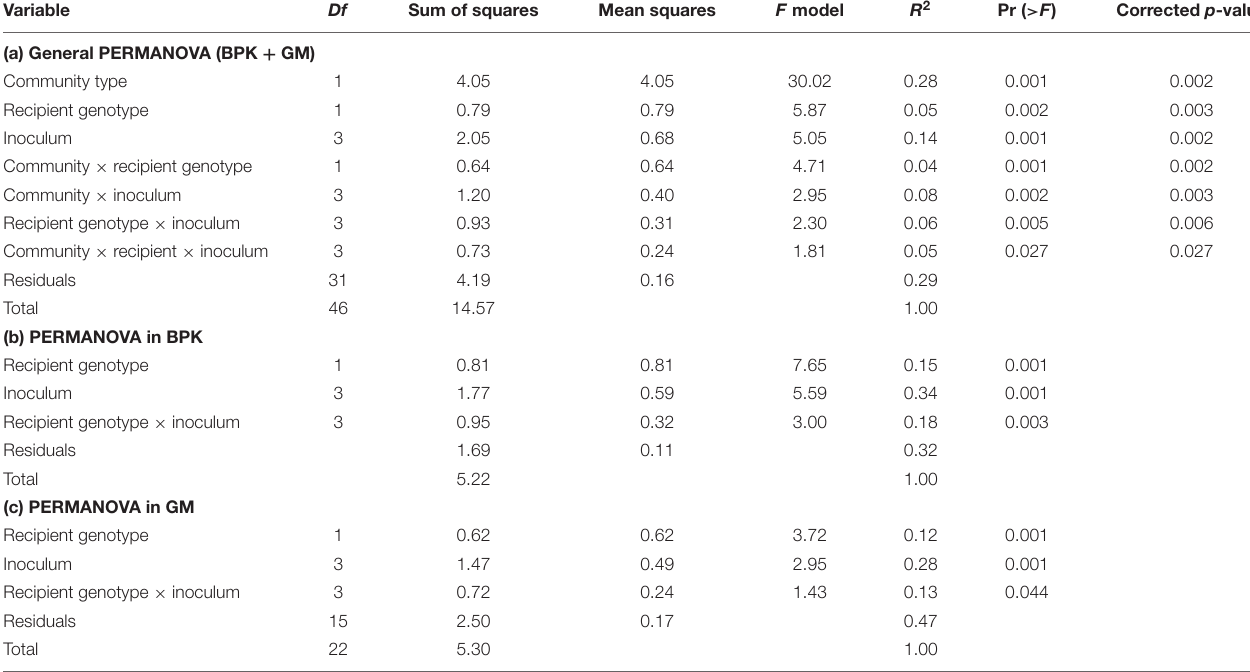
TABLE 2 | Effects of community type, microbiome inoculum, and recipient genotype on the taxonomic composition of microbial communities (Experiment 2).